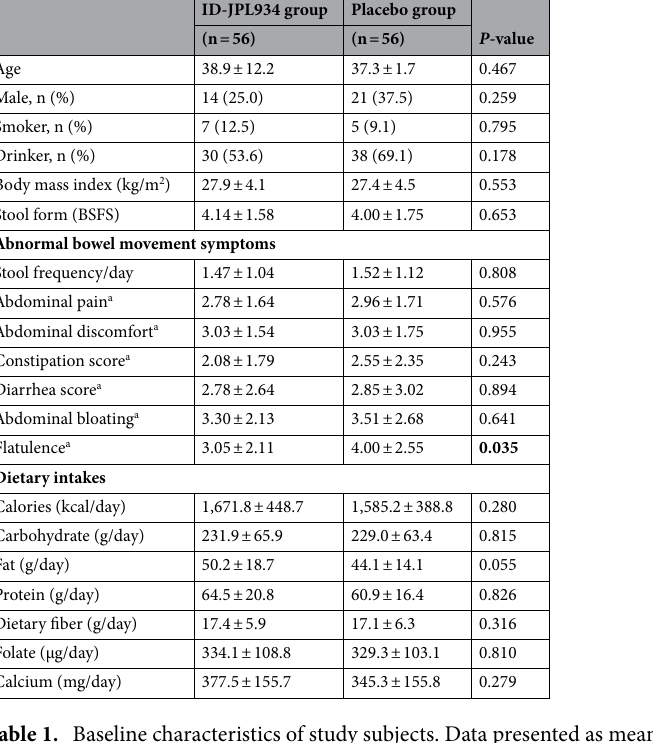
Table 1. Baseline characteristics of study subjects. Data presented as mean ± SD. P -values were calculated by either χ 2 test (categorical variables) or Student’s t-test (continuous variables). a Visual analog scale (0–10). BMI, body mass index; BSFS, Bristol Stool Form Scale. Bold style indicates statistical